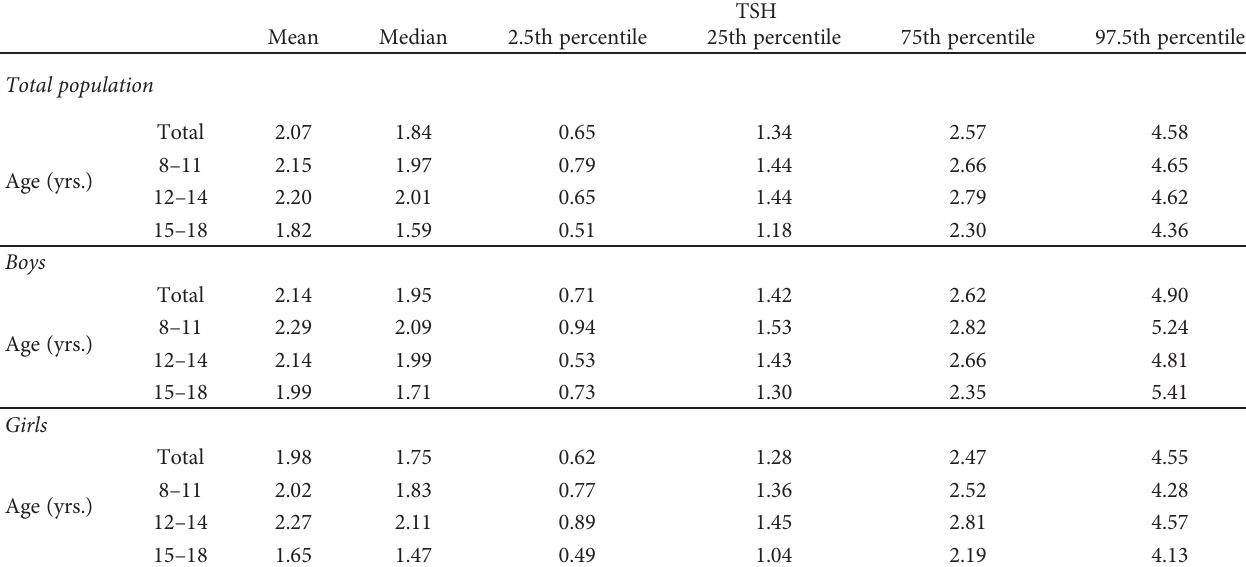
Table 3: TSH values according to age and sex in the overall population.